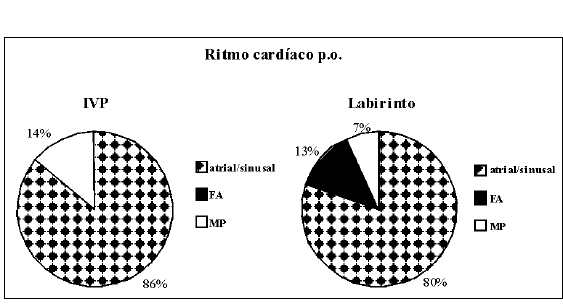
Fig. 2 - Comparação entre os ritmos cardíacos das séries IVP e